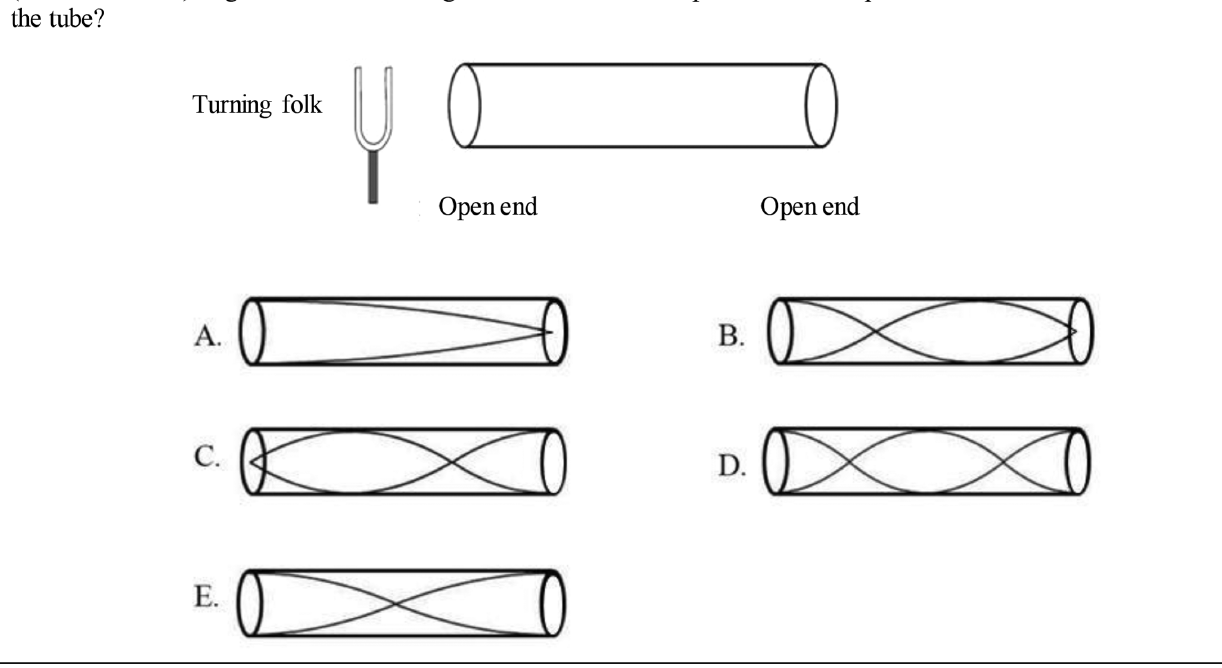
FIG. 1. Original and new question 21 (added to the modified version of the survey) in which we changed the way the concept was evaluated. The new question has the same format as the original question